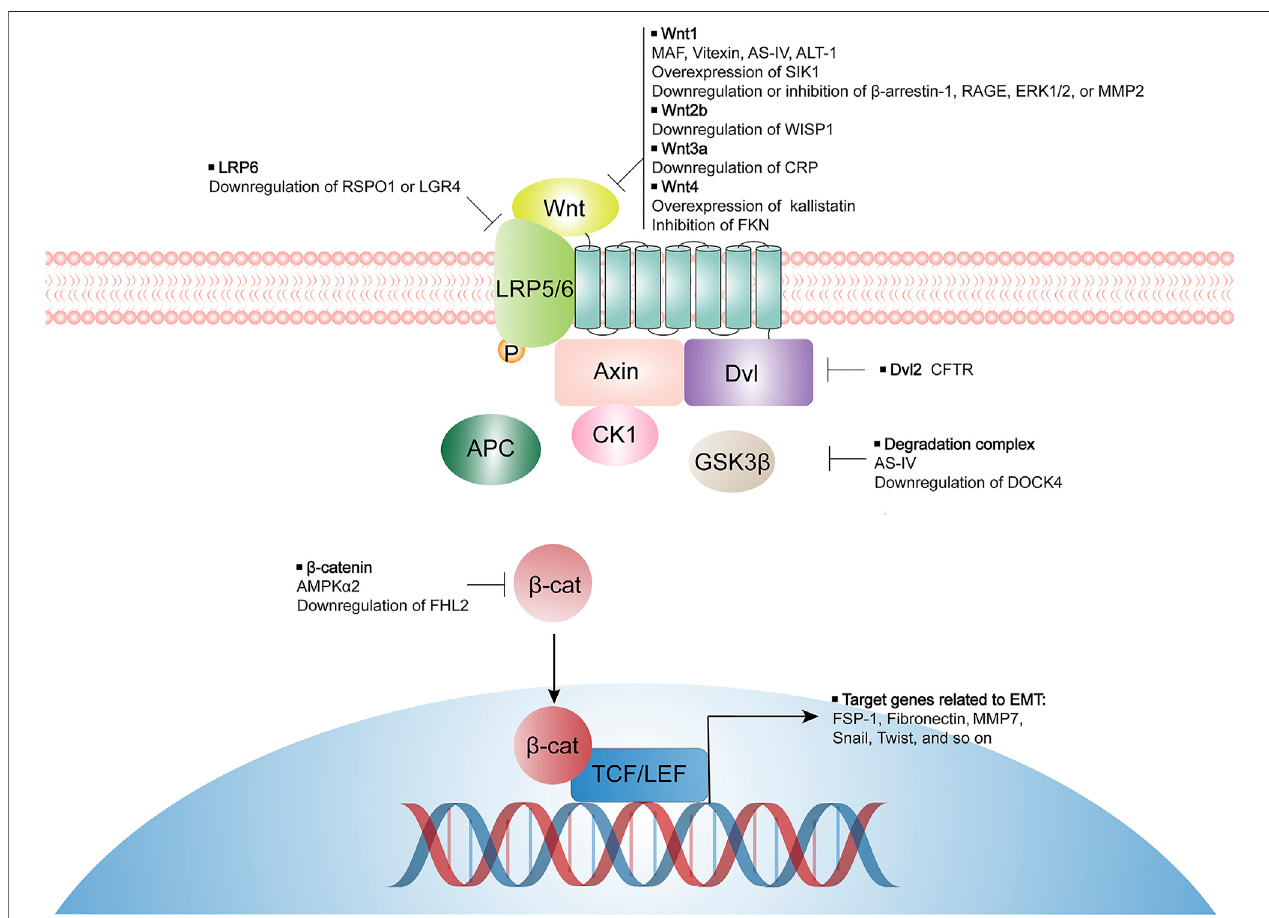
FIGURE 1 | Modulators for inhibiting tubular EMT and their potential targeted components of Wnt/ β -catenin pathway. LRP, lipoprotein receptor-related protein; Dvl, disheveled; GSK3 β , glycogen synthase kinase-3 β ; APC, adenomatous polyposis coli; MAF, 25-O-methylalisol F; AS-IV, Astragaloside IV; ATL-1, Atractylenolide I; SIK1, salt inducible kinase 1; RAGE, receptor of advanced glycation end-products; ERK, extracellular signal-regulated kinase; MMP, matrix metalloproteinase; WISP1, Wnt-inducible signaling pathway protein-1; CRP, C-reactive protein; FKN, fractalkine; RSPO1, R-spondin 1; LGR4, leucine-rich repeat-containing G protein coupled receptor 4; CFTR, cystic fi brosis transmembraneconductance regulator; DOCK4, dedicator ofcytokinesis 4;AMPK,AMP-activated protein kinase; FHL2, four and a half LIM domain protein